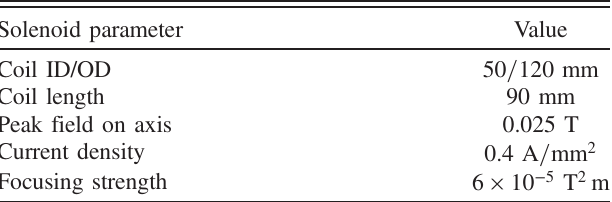
TABLE III. Parameters of the focusing solenoid at the accel- erator inlet.